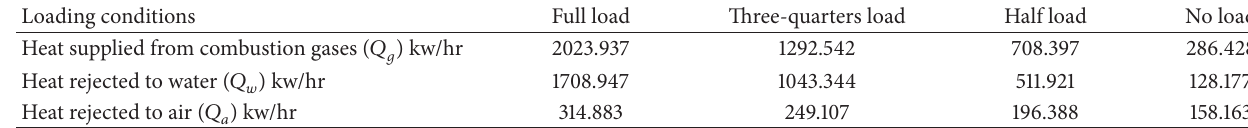
Table 4: Simulated and experimental temperature.